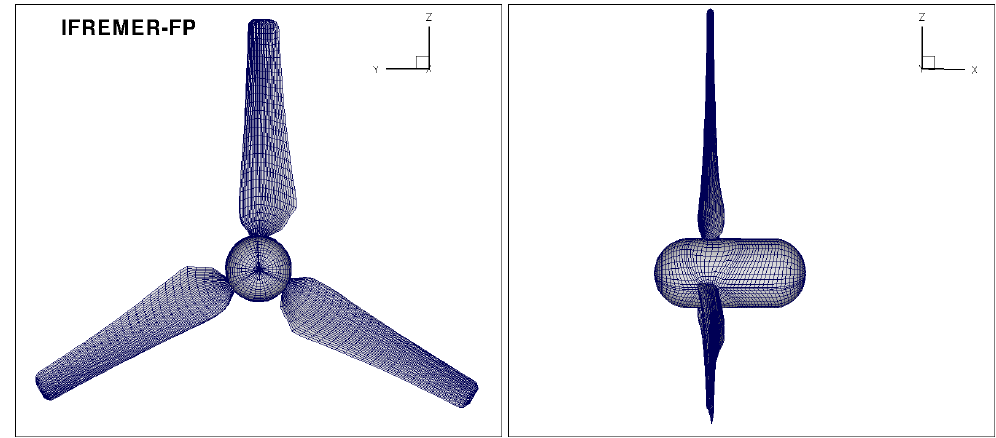
Figure 5. IFREMER-FP turbine. Computational grid used for calculations by